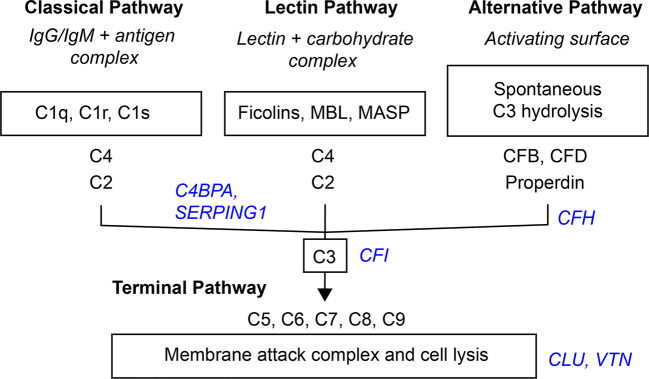
Simplified scheme of the three activation- and terminal complement pathway. Inhibitors in blue italic.